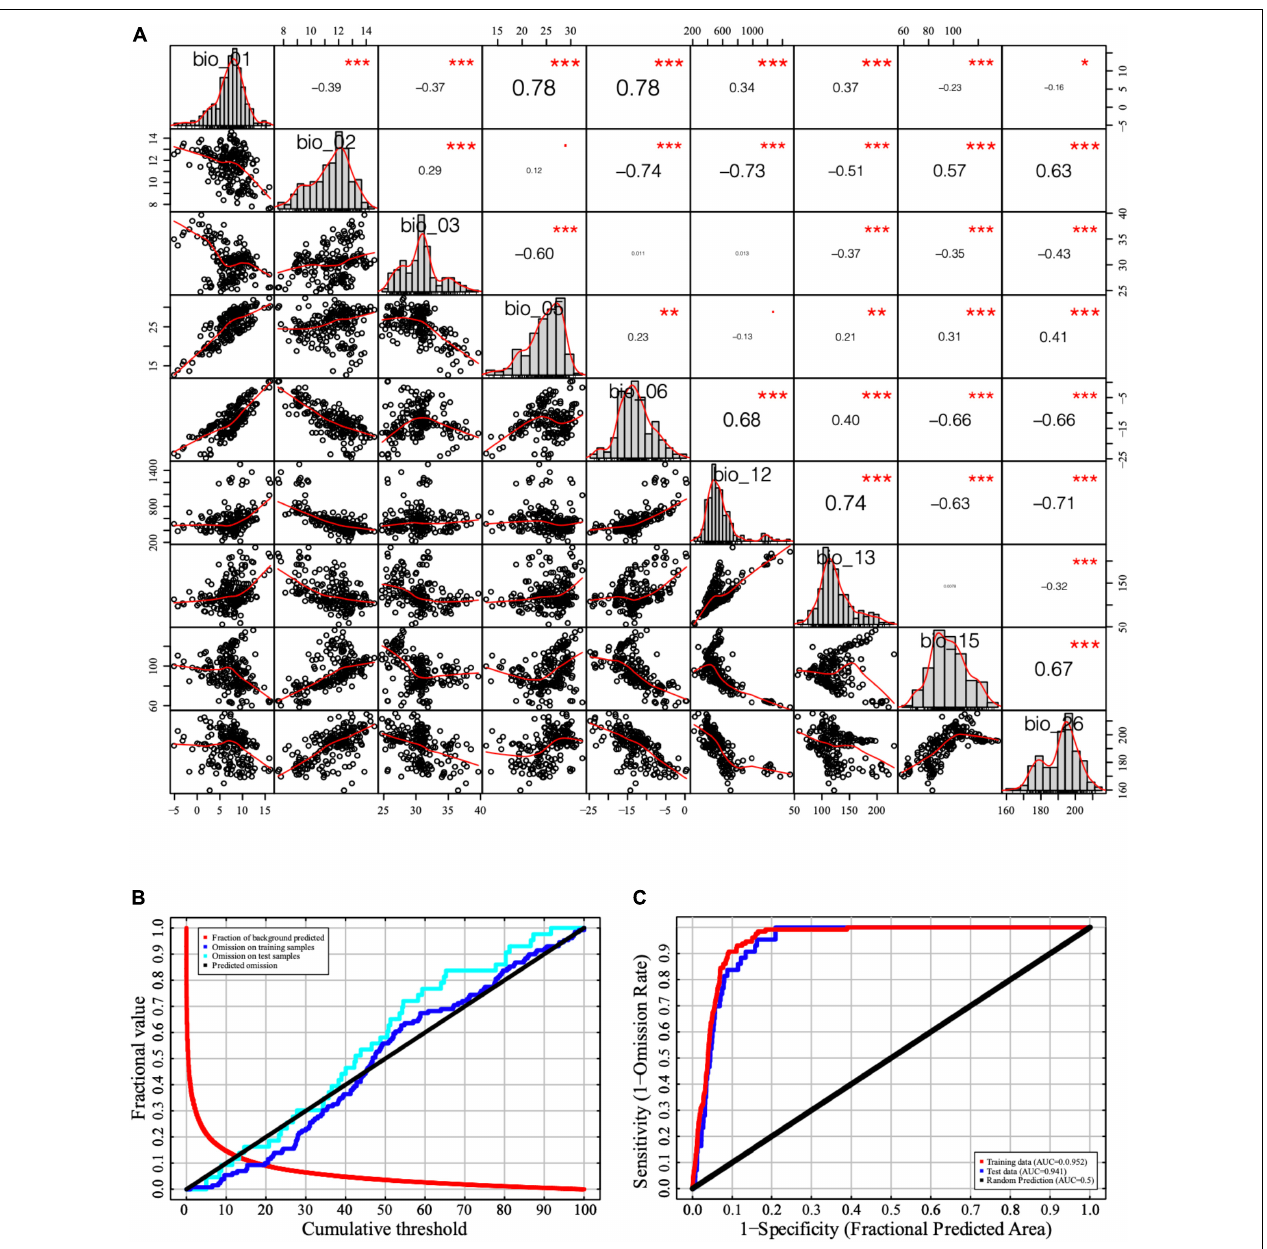
FIGURE 1 | Bioclimatic/environmental variable correlation analysis and model evaluation. (A) Correlation analysis of the independent variables. (B) Change in receiver operating characteristic (ROC) curve. (C) Change in area under the curve (AUC). The symbols of “***”, “**,” and “*” represent significance level of p -value “0–0.001,” “0.001–0.01,” and